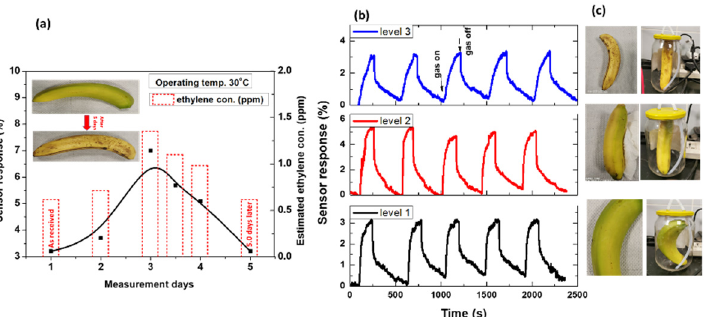
Table 1. The most recent chemiresistive C 2 H 4 sensors reported in the literature.